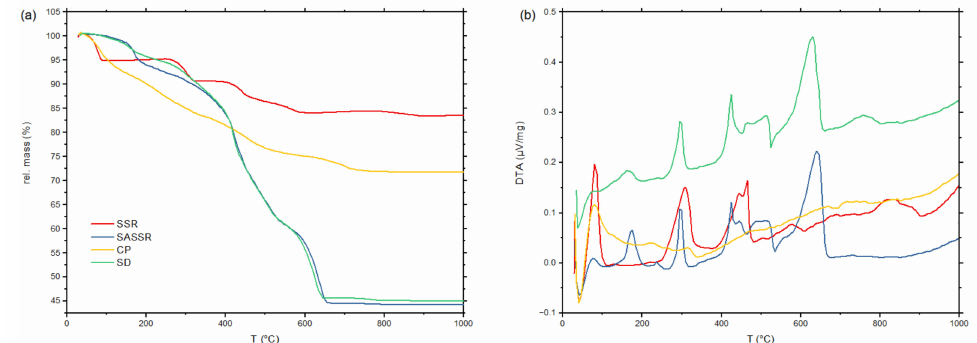
Figure 2. ( a ) Thermogravimetric (TG) and ( b ) differential thermal analysis (DTA) curves for the samples obtained using four different synthesis routes (red—SSR; blue—SASSR; yellow—SD; green— CP). No more mass change can be observed above 900 ◦ C for all